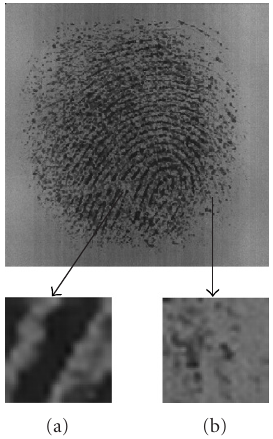
Figure 4: The illustration of block clusters degree: (a) CluD is big- ger and (b) CluD is smaller.